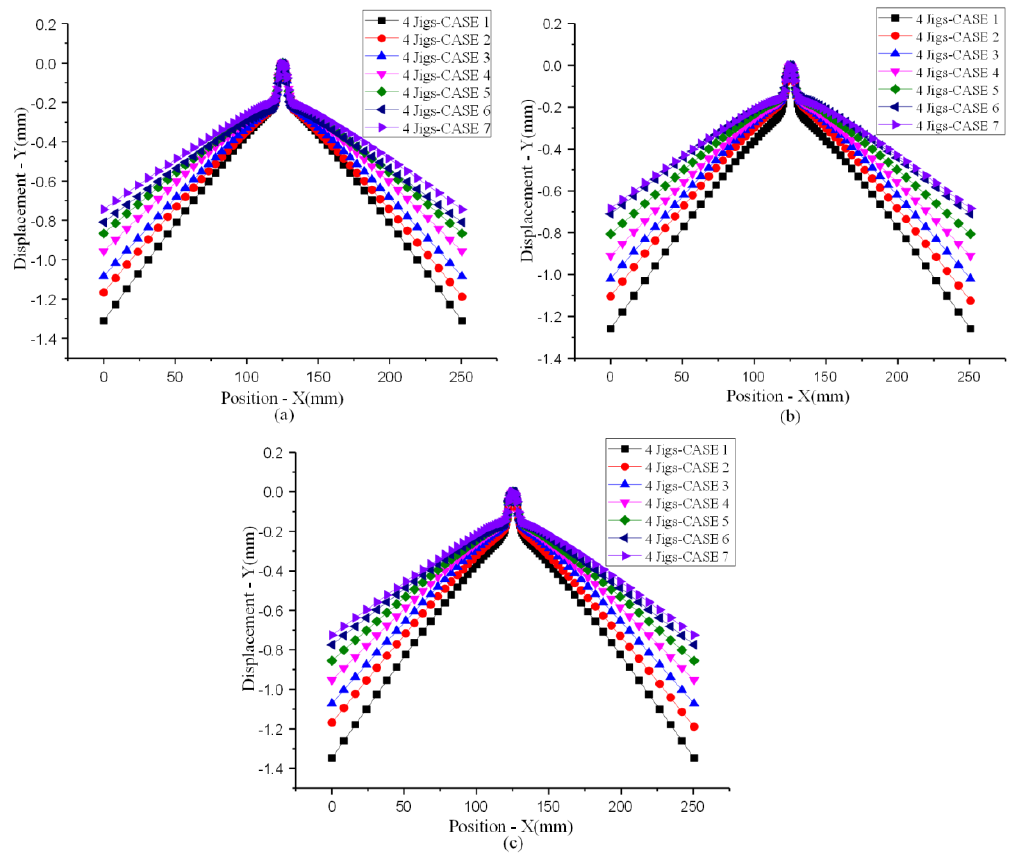
Figure 17. Y-deformation using an applied jig fixture with a depressed displacement of 0 mm: ( a ) line 1; ( b ) line 2; ( c ) line 3.